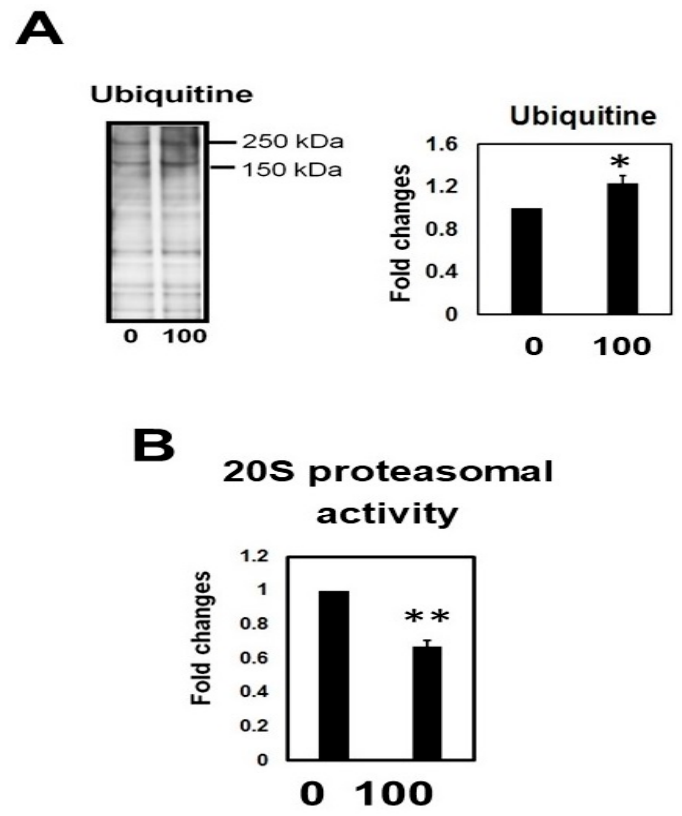
Figure 12. Homocysteine (Hcy) downregulated the ubiquitin proteasomal system ( A ). 0: 0 µM of Hcy, 100: 100 µM homocysteine. The amount of ubiquitinated protein is increased. N = 4, * p < 0.05, Bar: + SD ( A ). 20S proteasome activity (chymotrypsin-like activity) also was downregulated. N = 4, ** p < 0.01, Bar: ± SD ( B ).